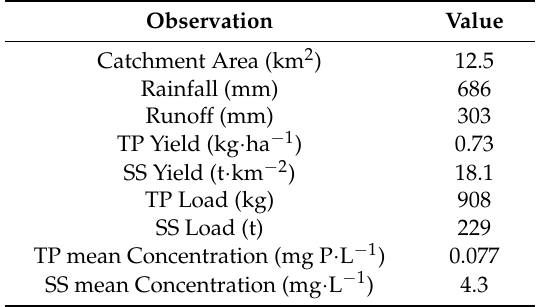
Table 1. Observations at the NBC April–September 2012 from monitoring